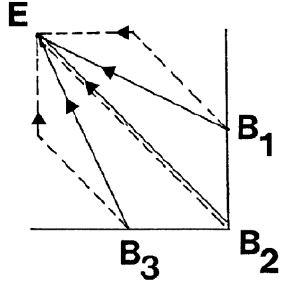
Figure 3. Three movements composed of two joints are represented. The start points are B1, B2 and B3 and the end point is the same for all of them: E. Solid lines represent the right way to perform the movement and the dotted lines indicate a composite of two actions. This is a graph taken from